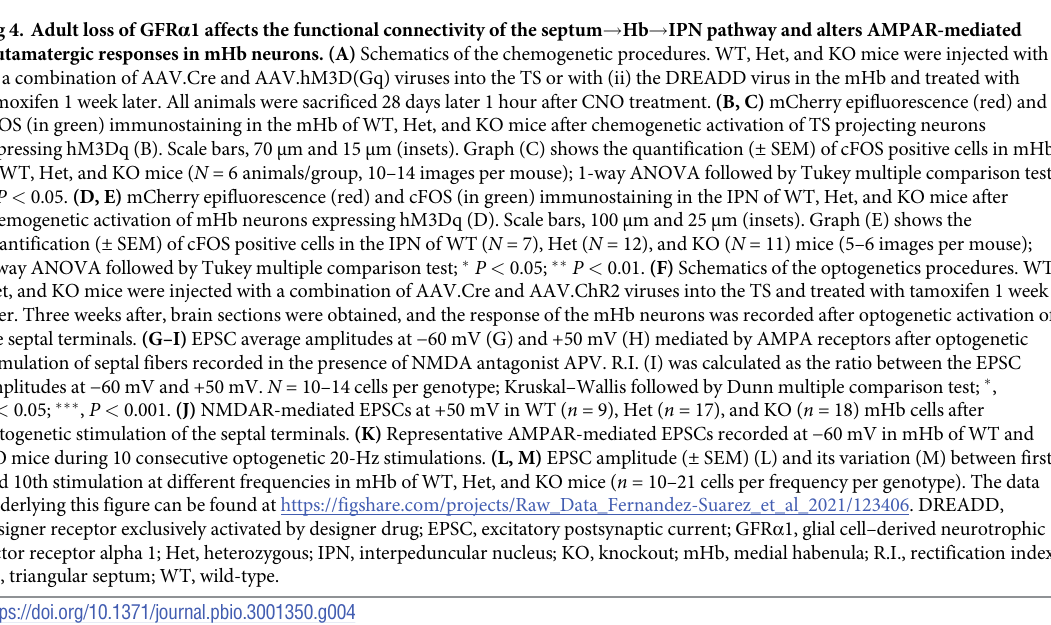
Fig 4. Adult loss of GFR α 1 affects the functional connectivity of the septum ! Hb ! IPN pathway and alters AMPAR-mediated glutamatergic responses in mHb neurons. (A) Schematics of the chemogenetic procedures. WT, Het, and KO mice were injected with (i) a combination of AAV.Cre and AAV.hM3D(Gq) viruses into the TS or with (ii) the DREADD virus in the mHb and treated with tamoxifen 1 week later. All animals were sacrificed 28 days later 1 hour after CNO treatment. (B, C) mCherry epifluorescence (red) and cFOS (in green) immunostaining in the mHb of WT, Het, and KO mice after chemogenetic activation of TS projecting neurons expressing hM3Dq (B). Scale bars, 70 μ m and 15 μ m (insets). Graph (C) shows the quantification ( ± SEM) of cFOS positive cells in mHb of WT, Het, and KO mice ( N = 6 animals/group, 10–14 images per mouse); 1-way ANOVA followed by Tukey multiple comparison test; � , P < 0.05. (D, E) mCherry epifluorescence (red) and cFOS (in green) immunostaining in the IPN of WT, Het, and KO mice after chemogenetic activation of mHb neurons expressing hM3Dq (D). Scale bars, 100 μ m and 25 μ m (insets). Graph (E) shows the quantification ( ± SEM) of cFOS positive cells in the IPN of WT ( N = 7), Het ( N = 12), and KO ( N = 11) mice (5–6 images per mouse); 1-way ANOVA followed by Tukey multiple comparison test; � P < 0.05; �� P < 0.01. (F) Schematics of the optogenetics procedures. WT, Het, and KO mice were injected with a combination of AAV.Cre and AAV.ChR2 viruses into the TS and treated with tamoxifen 1 week later. Three weeks after, brain sections were obtained, and the response of the mHb neurons was recorded after optogenetic activation of the septal terminals. (G–I) EPSC average amplitudes at − 60 mV (G) and +50 mV (H) mediated by AMPA receptors after optogenetic stimulation of septal fibers recorded in the presence of NMDA antagonist APV. R.I. (I) was calculated as the ratio between the EPSC amplitudes at − 60 mV and +50 mV. N = 10–14 cells per genotype; Kruskal–Wallis followed by Dunn multiple comparison test; � , P < 0.05; ��� , P < 0.001. (J) NMDAR-mediated EPSCs at +50 mV in WT ( n = 9), Het ( n = 17), and KO ( n = 18) mHb cells after optogenetic stimulation of the septal terminals. (K) Representative AMPAR-mediated EPSCs recorded at − 60 mV in mHb of WT and KO mice during 10 consecutive optogenetic 20-Hz stimulations. (L, M) EPSC amplitude ( ± SEM) (L) and its variation (M) between first and 10th stimulation at different frequencies in mHb of WT, Het, and KO mice ( n = 10–21 cells per frequency per genotype). The data underlying this figure can be found at https://figshare.com/projects/Raw_Data_Fernandez-Suarez_et_al_2021/123406. DREADD, designer receptor exclusively activated by designer drug; EPSC, excitatory postsynaptic current; GFR α 1, glial cell–derived neurotrophic factor receptor alpha 1; Het, heterozygous; IPN, interpeduncular nucleus; KO, knockout; mHb, medial habenula; R.I., rectification index; TS, triangular septum; WT, wild-type.